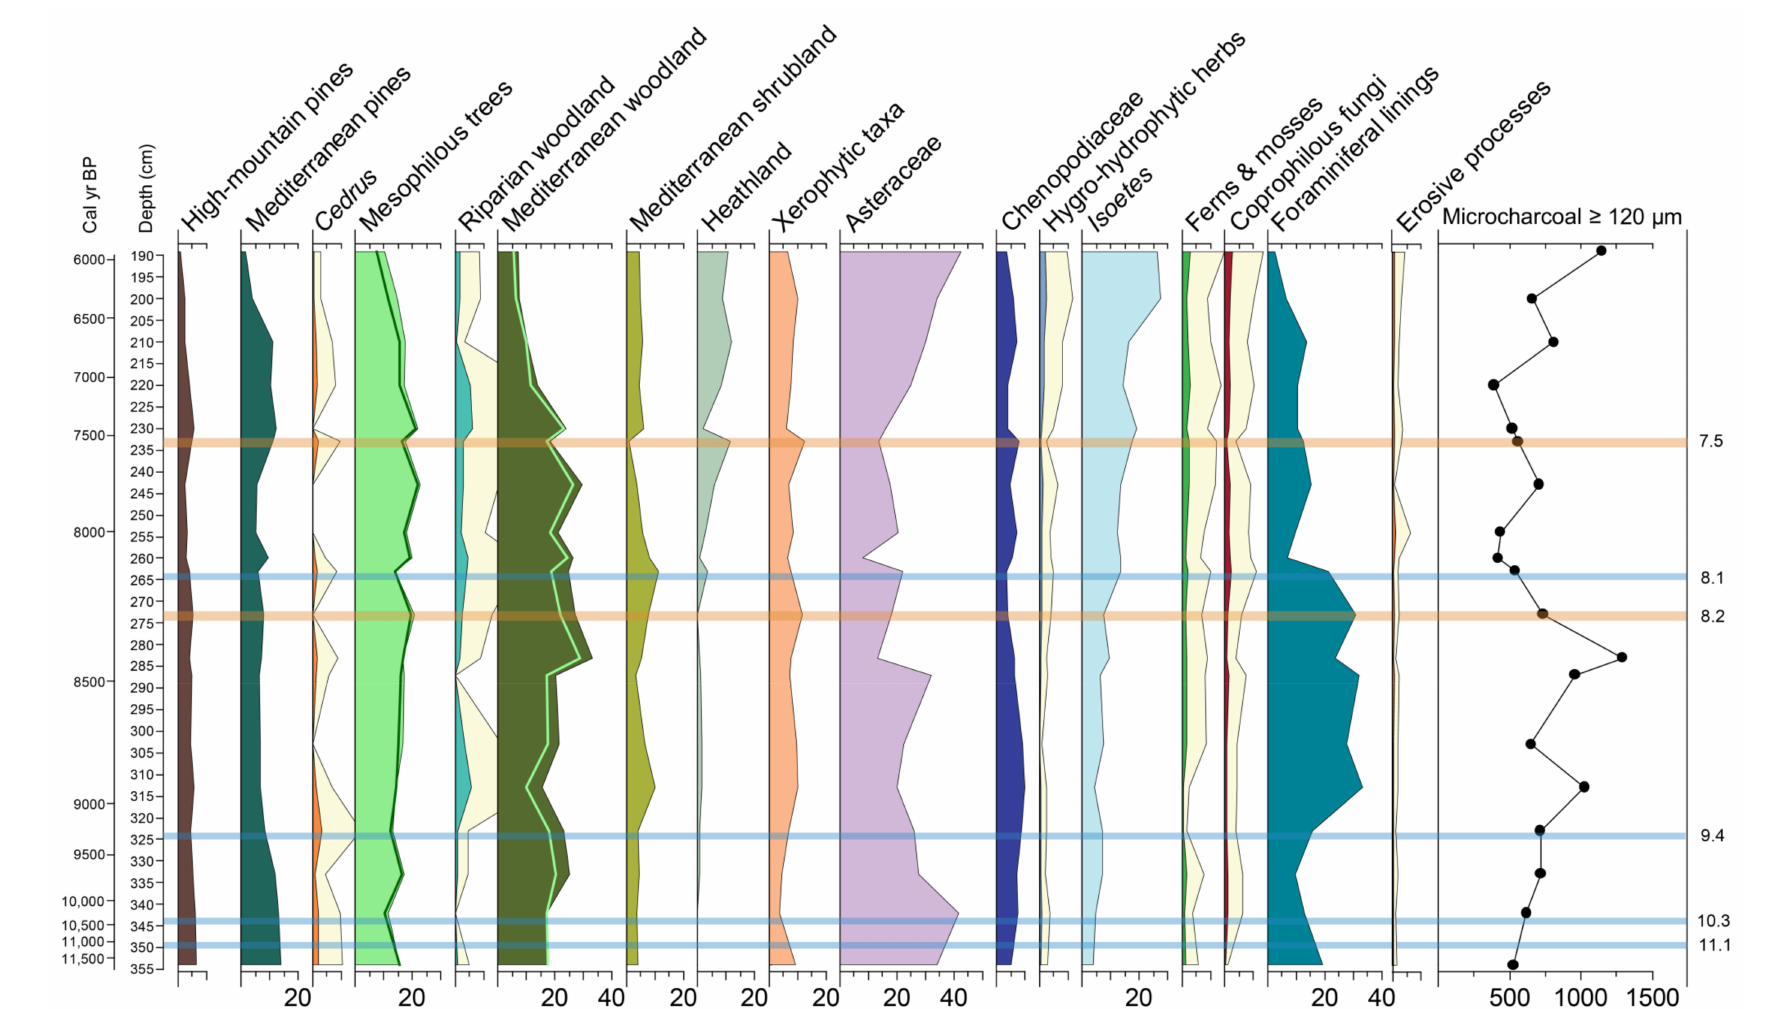
Figure 7. Synthetic diagram of the main ecological groups and taxa expressed in percentages. The dark green line plotted against the Mesophilous trees represents deciduous Quercus values, while the light green line plotted against the Mediterranean woodland shows evergreen Quercus values. Microcharcoals are expressed in concentrations (particles/gr of dry sediment). Blue lines correspond to the IRD events (Bond et al., 1997) with a clear impact in the vegetation identified in the core 19-01, while orange lines highlight aridity